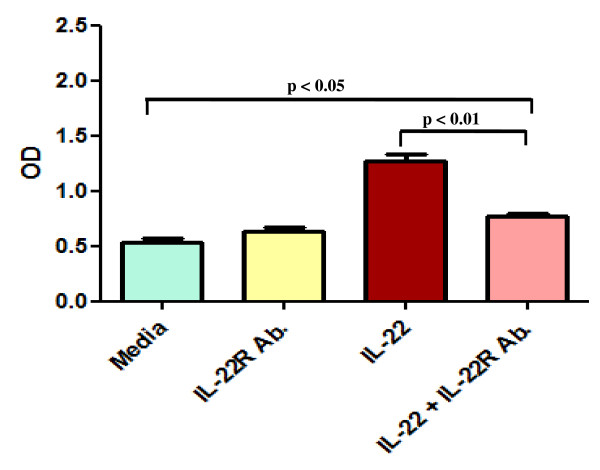
Human anti IL-22R antibody significantly inhibited rIL-22 induced FLS proliferation in PsA. FLS were pretreated with anti IL-22R antibody (1000 ng/ml) for 1 hr then incubated with rIL-22 (100 ng/ml) at 37°C for 5 days. MTT assay was done to evaluate the inhibitory effect of anti IL-22R antibody (IL-22R Ab). Each experiment was done in triplicate. Results were expressed as Mean ± SEM of OD. Non parametric test, Friedman's ANOVA with Dunn's multiple comparison test was done to determine statistical significance.